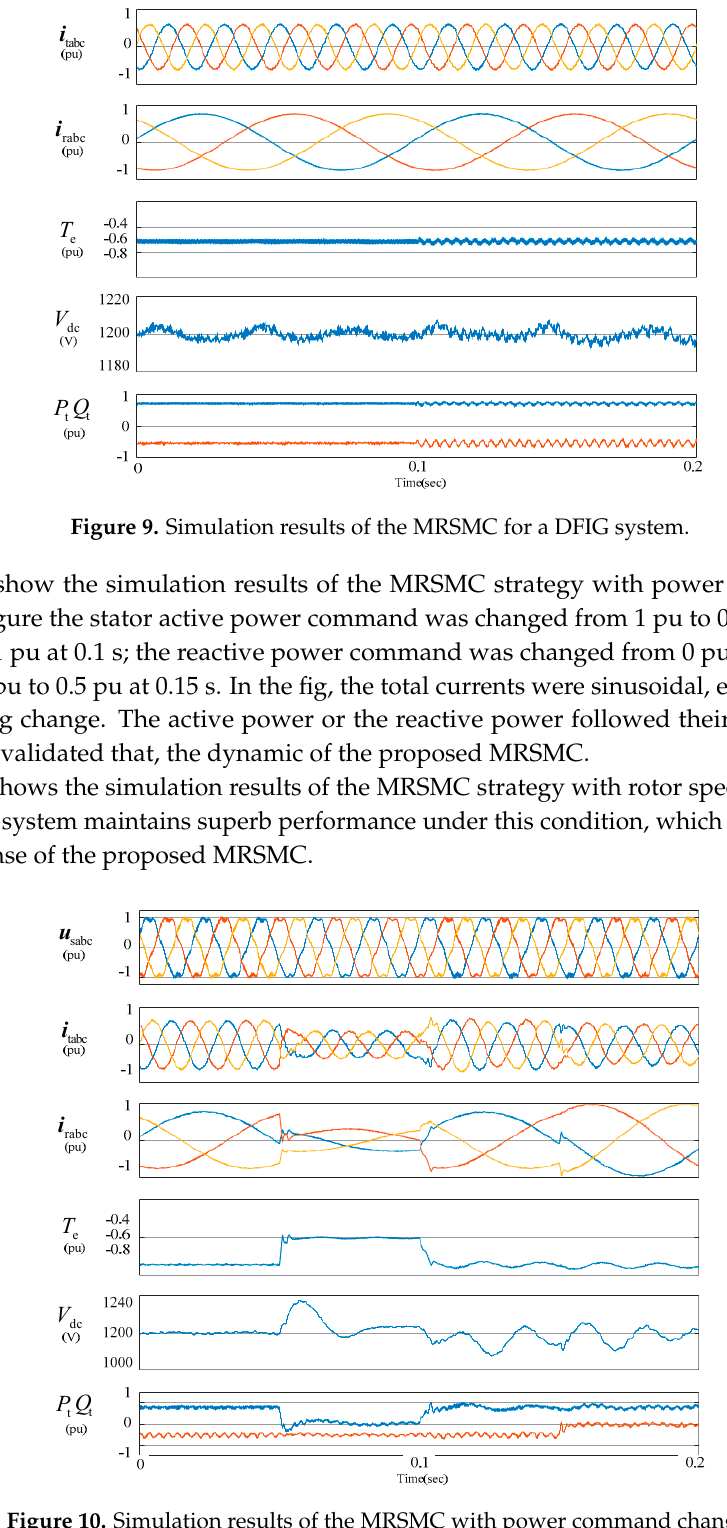
Figure 10. Simulation results of the MRSMC with power command change.